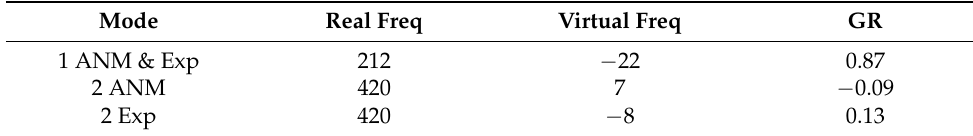
Figure 12. Instability prediction of the ANM. Table 4. Growth rate GR of